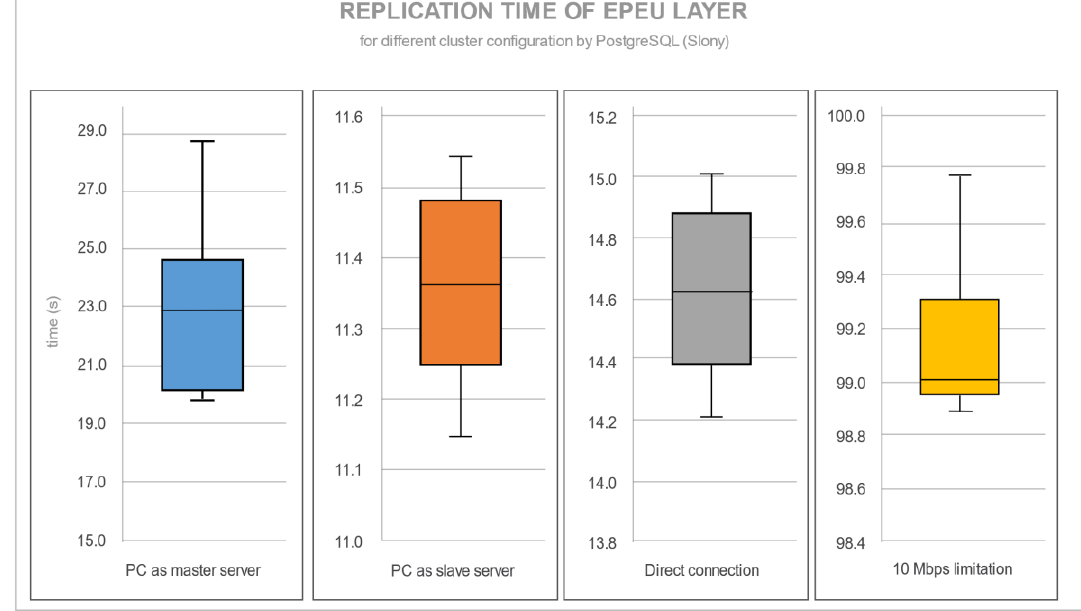
Figure 10. Replication time of the EPEU layer for di ff erent cluster configurations by PostgreSQL (Slony).